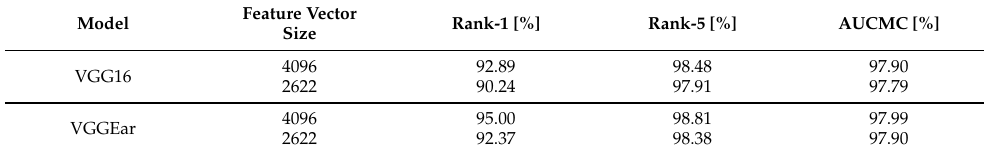
Figure 8. Using the t-SNE algorithm [41], 2D embedded feature vectors were generated for the VGGFace-Ear validation and test sets using the penultimate layer of both models. The first row depicts feature vectors using the VGG16 while the second row, feature vectors using the VGGEar. Every color cluster represents a class in the sets. ( a ) validation set with 80 samples per class and ( b ) test set with 150 samples. The number of classes was reduced to 60 for better visualization. Images elaborated by the author. Table 7. Performance evaluation of the two fine-tuned models over the VGGFace-Ear test